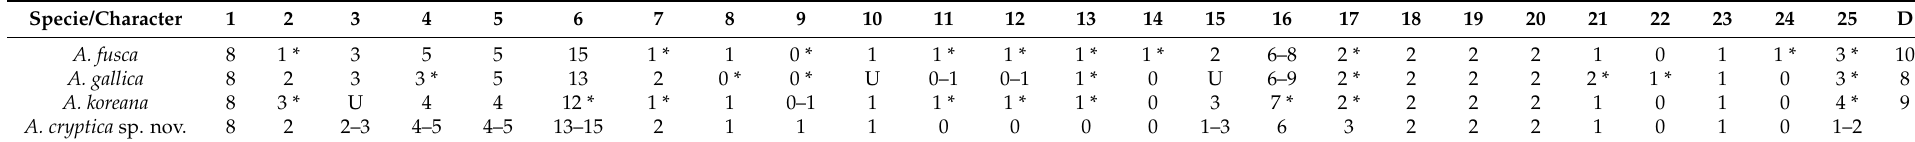
Legend for the headers of the columns: (1) eyes number; (2) post antennal chaetae shape: short and rounded, all ciliated = 1; long, pointed or rounded = 2; rounded, but ciliated only at terminal half = 3; (3) ant II, number of ventral chaetae; (4) ant II, number of thick chaetae; (5) ant III, number of thick chaetae; (6) ant IV sub-segments; (7) posterodorsal gland on large abdomen: flat = 1; prominent = 2; (8) head, surface sculpture of Mc: scale-like = 0; scale-like and pointed = 1; (9) claw, internal teeth number; (10) claw, presence of tunica: absent = 0; present = 1; (11) empodium L1, presence of internal tooth: absent = 0; present = 1; (12) same as (11) for empodium L2; (13) same as (11) for empodium L3; (14) empodium, additional apical teeth number; (15) empodium filament/claw relation: filament shorter than claw = 1; similar = 2; filament longer than claw = 3; (16) manubrium dorsal, chaetae each side; (17) dens, anterior chaetae, row 1 number; (18) dens, anterior chaetae, row 2 number; (19) dens, anterior chaetae, row 3 number; (20) dens, anterior chaetae, row 4 number; (21) dens, anterior chaetae, row 5 number; (22) dens, anterior chaetae, row 6 number; (23) dens, anterior chaetae, row 7 number; (24) dens, outer and posterior chaetae: normal or similar to the rest = 0; long and knobbed = 1; (25) anal appendage tip shape: pointed = 1; blunt = 2; broadened at its total length = 3; spatulated = 4. U, unknown; *, different for the character with the new species; D, total number of differences between the species and the new